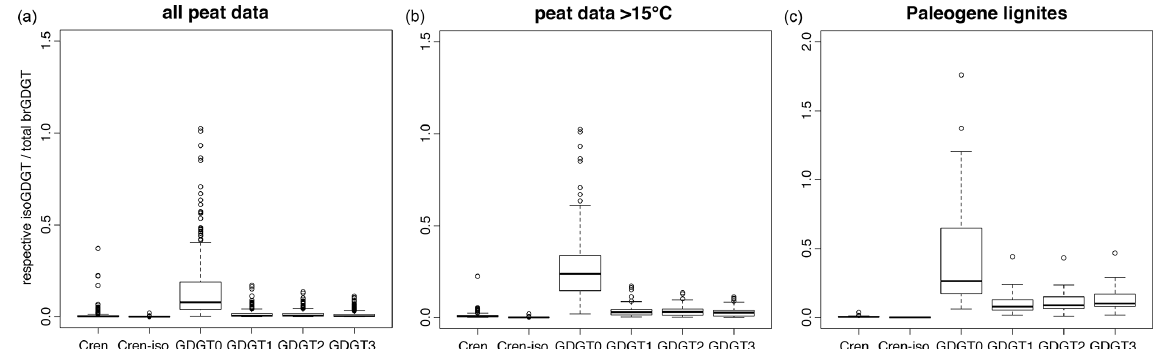
Figure 5. The abundance of various isoGDGTs relative to the total brGDGT abundance in modern peats (a, b) and Paleogene lignites ( a ; Eq. 9) used to assess potential isoGDGT contributions to the ACEX samples. The box represents standard 25%–50%–75% quantiles, and whiskers represent the box limits plus or minus 1 . 5 × the interquartile range (IQR). Any data outside that range are given as circles. The number of measurements per dataset are as follows. Modern peats: 473 (most isoGDGTs have been identified in ± 430 of those); modern peats above 15 ◦ C: 141 (all except one have isoGDGT data); lignites: 58 (all of which have isoGDGT data but only 29 have available and quantifiable crenarchaeol isomer data).